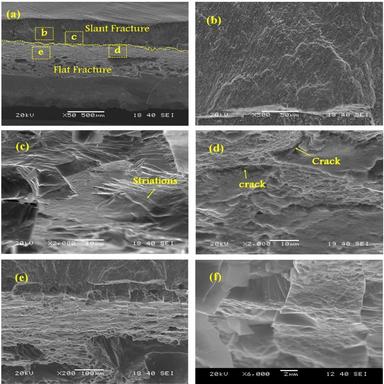
Typical fatigue fracture surfaces of samples brazed with 4 kW laser power tested at strain amplitude of 0.04: the terms "b, c, d, e" represents locations of various fatographs represented in rest of the figures; (a) entire fracture surface at low magnification, (b) flow line pattern on slant fracture surface, (c) fatigue striations, (d) intergranular cracking, (e) flat fracture surface and (f) fracture features at galvanized steel.